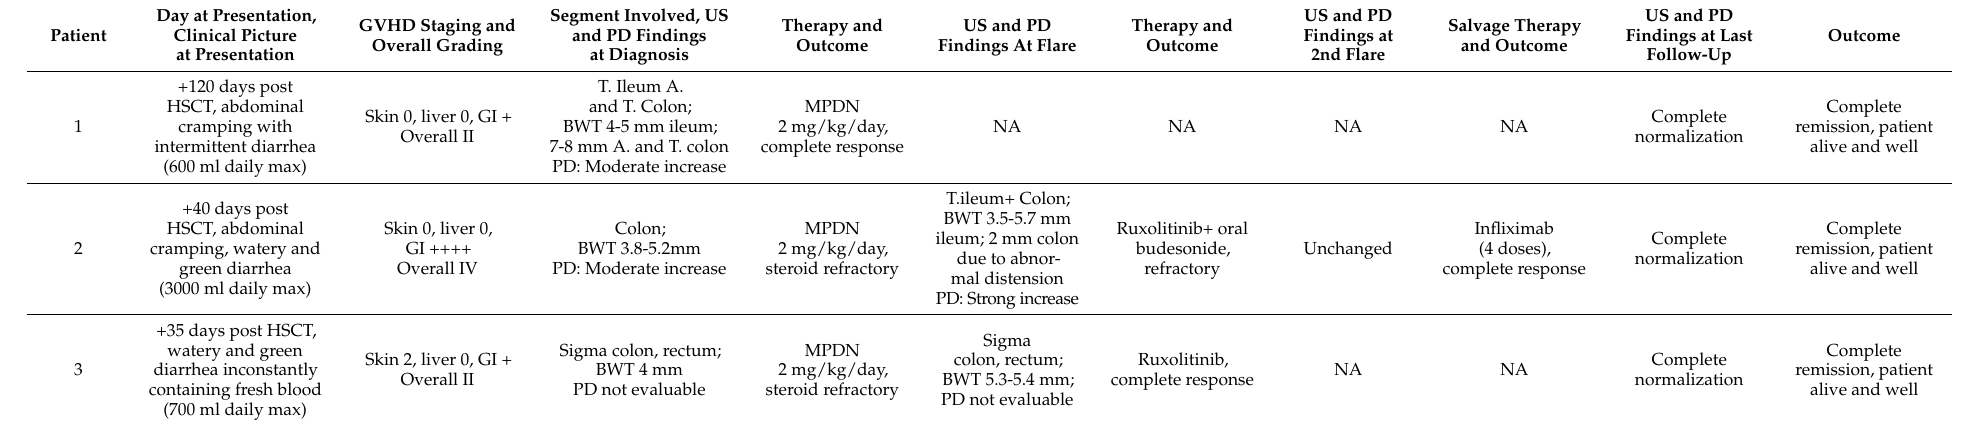
Table 2. Standard US and power Doppler findings at diagnosis, GvHD flares, and follow-up along with therapy and clinical